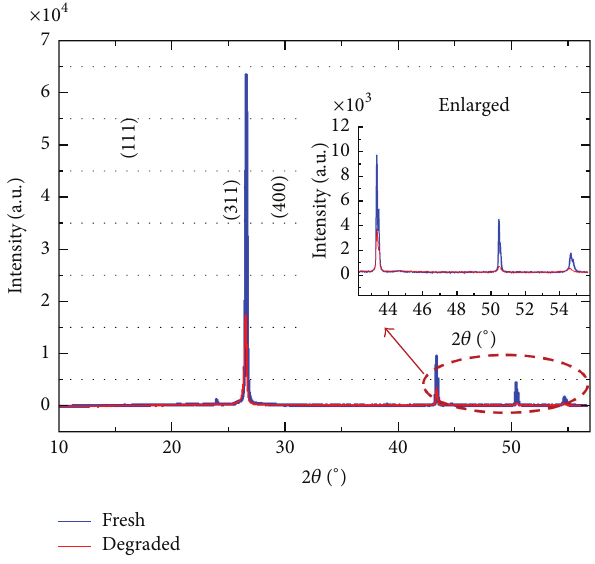
Figure 3: XRD spectra of graphite-based anode from fresh and degraded